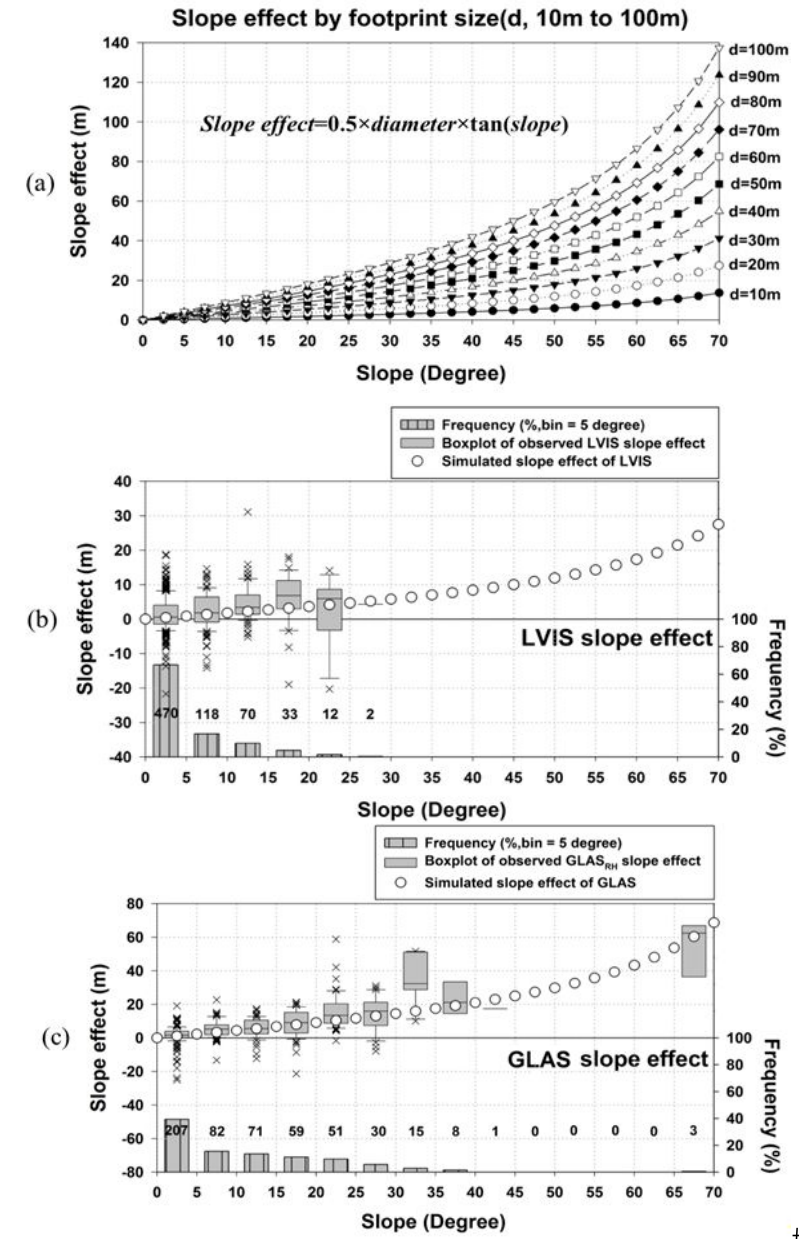
Figure 6. ( a ) Simulated theoretical terrain slope effects across different footprint sizes (10–100 m) and slope gradients (0°–70°). Errors in slope-uncorrected ( b ) LVIS and ( c ) GLAS metrics used in this study along with the simulated slope effects. Bar histograms represent the frequency (%) of LVIS and GLAS data given each slope range (numbers in plot represent number of lidar shots in each bin (not %)). Circles are the simulated slope effects of given footprint size and terrain slope (refer to Figure 6a) and box-whiskers plots correspond to errors in the LVIS and GLAS